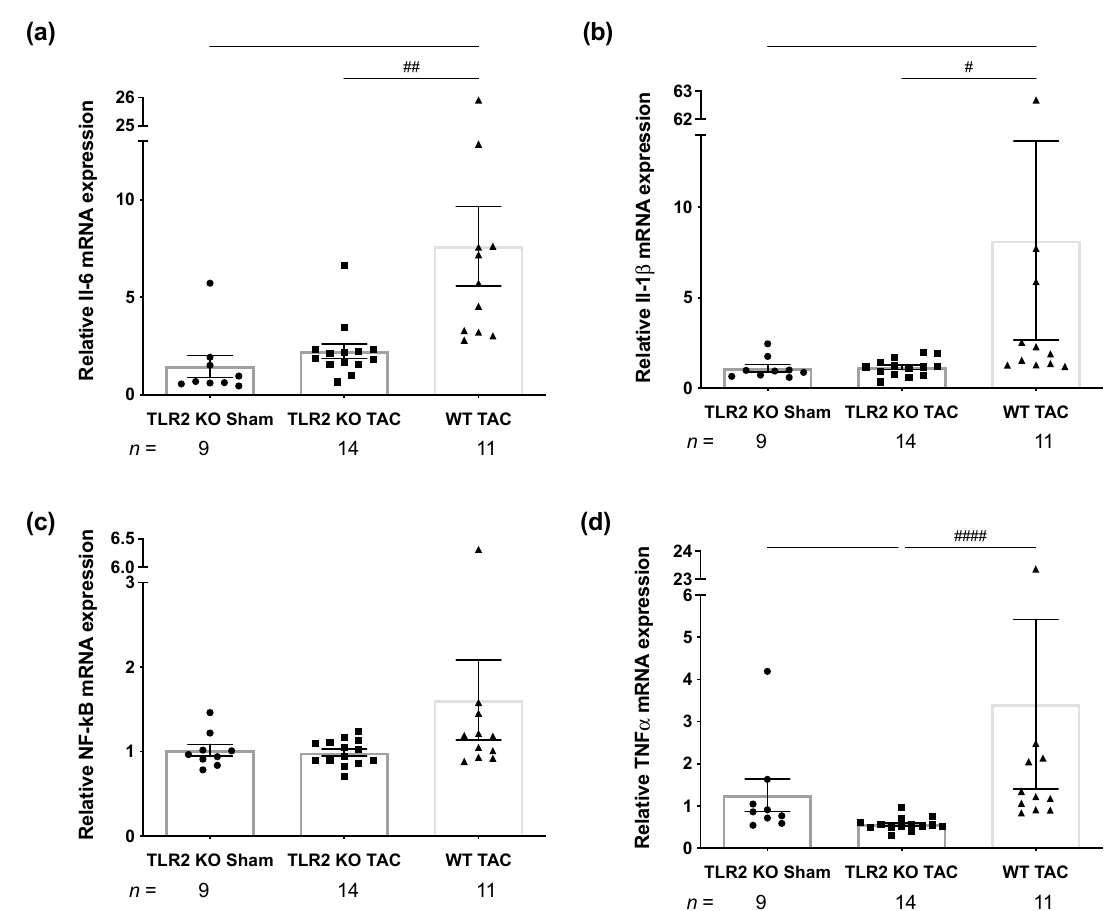
Figure 2. Inflammatory parameters in TLR2 KO and WT mice 12 weeks after sham or TAC surgery. ( a ) Relative mRNA expression of interleukin-6 (IL-6) by TaqMan RT-qPCR. ( b ) Relative mRNA expression of IL-1 β assessed by TaqMan RT-qPCR. ( c ) Relative mRNA expression of nuclear factor kappa-light-chain-enhancer of activated B cells (NF- κ B) by TaqMan RT-qPCR. ( d ) Relative mRNA expression of tumor necrosis factor-alpha (TNF- α ) by TaqMan RT-qPCR. Circles represent TLR2 KO TAC animals, squares TLR2 KO TAC animals and triangles WT TAC animals. n indicates number of mice per group. For IL-6, a one-way ANOVA followed by Tukey’s test was used, and for the rest, a Kruskal–Wallis followed by Dunn’s multiple comparison test was used: # p < 0.05, ## p < 0.01, #### p < 0.0001. Table 2. Tissue characteristics of TLR2 KO sham, TLR2 KO TAC and WT TAC mice 12 weeks after surgery. Values are mean ± SEM. TAC, transverse aortic constriction; KO, knockout; WT, wild type; n, number of animals; HW/TL, heart weight to tibia length ratio; LuW/TL, lungs weight to tibia length ratio; LiW/TL, liver weight to tibia length ratio; KW/TL, average kidney weight to tibia